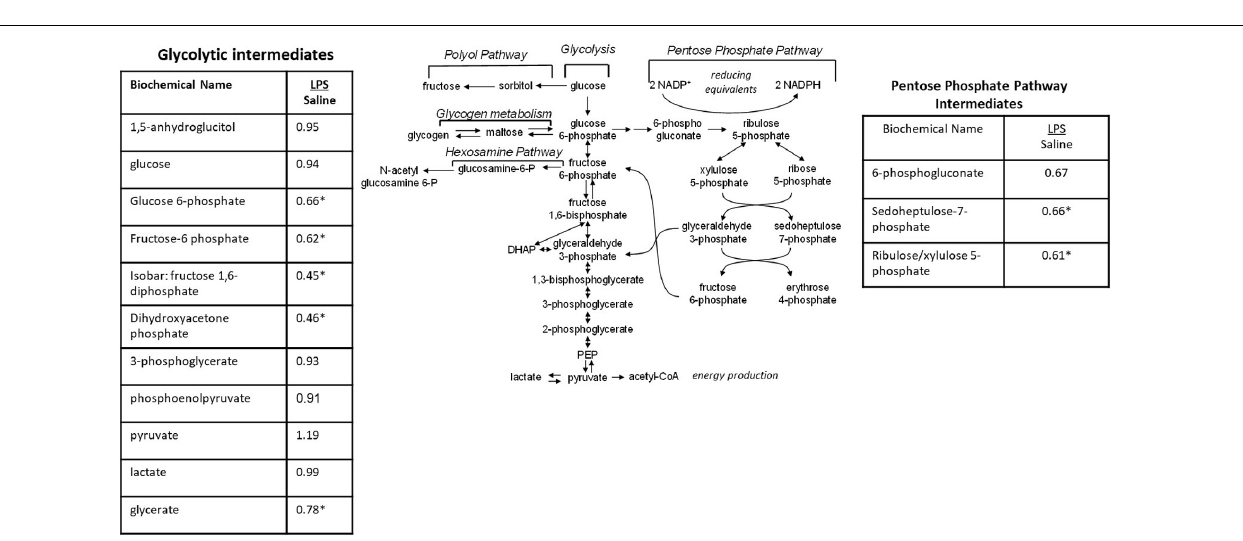
FIGURE 4 | Acylcarnitine metabolism is disrupted in LPS Placenta. Relative values of differentially expressed metabolites in LPS placenta expressed as fold change of controls. ∗ Significantly different between LPS and control placenta, p ≤ 0.05 and q ≤ 0.05. ∗∗ Significantly different between LPS and control placenta, p ≤ 0.05 and q ≤ 0.1. Box plots of 3-hydroxybutryate in LPS (black boxes) and control (white boxes). N = 8 both groups.